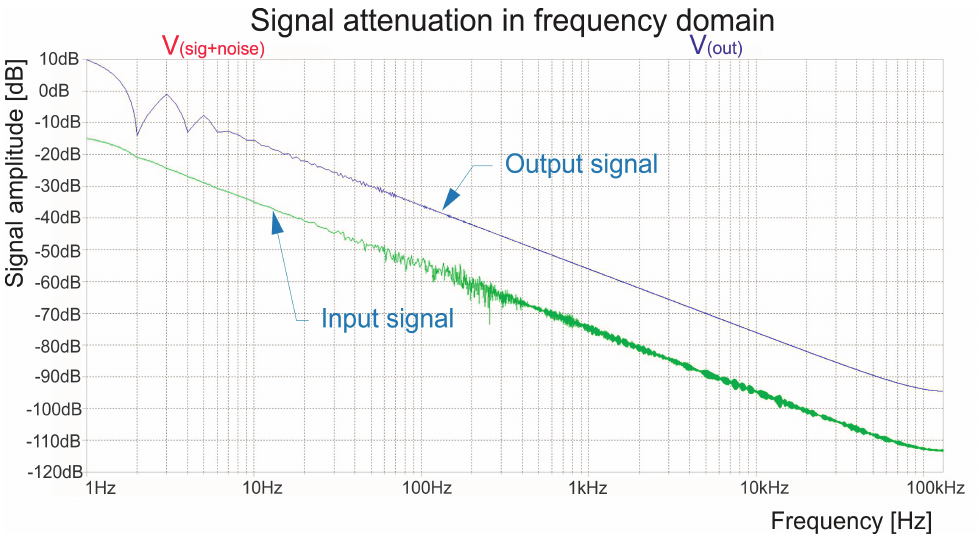
Figure 8. Frequency response of the used